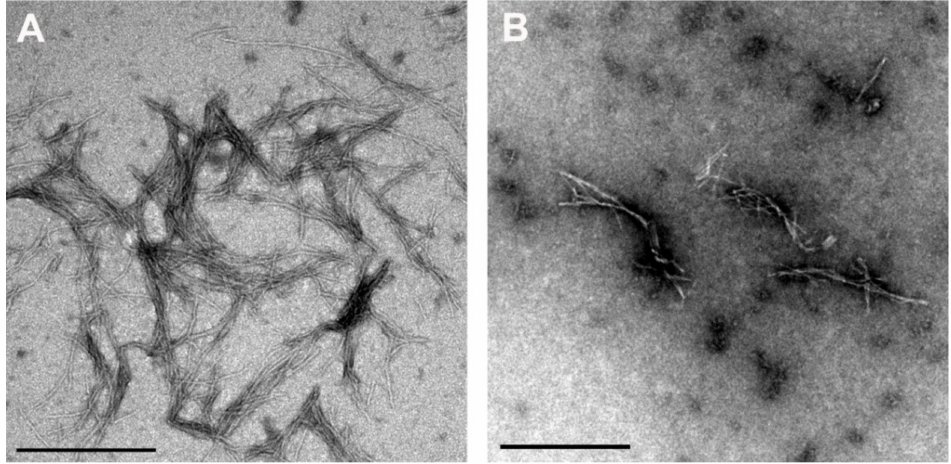
Figure 6. TEM images of stB fibrils at the plateau phase ( A ) alone or ( B ) at 4 µ M Quer + 0.5 mM vitC. Scale bars = 0.5 µ